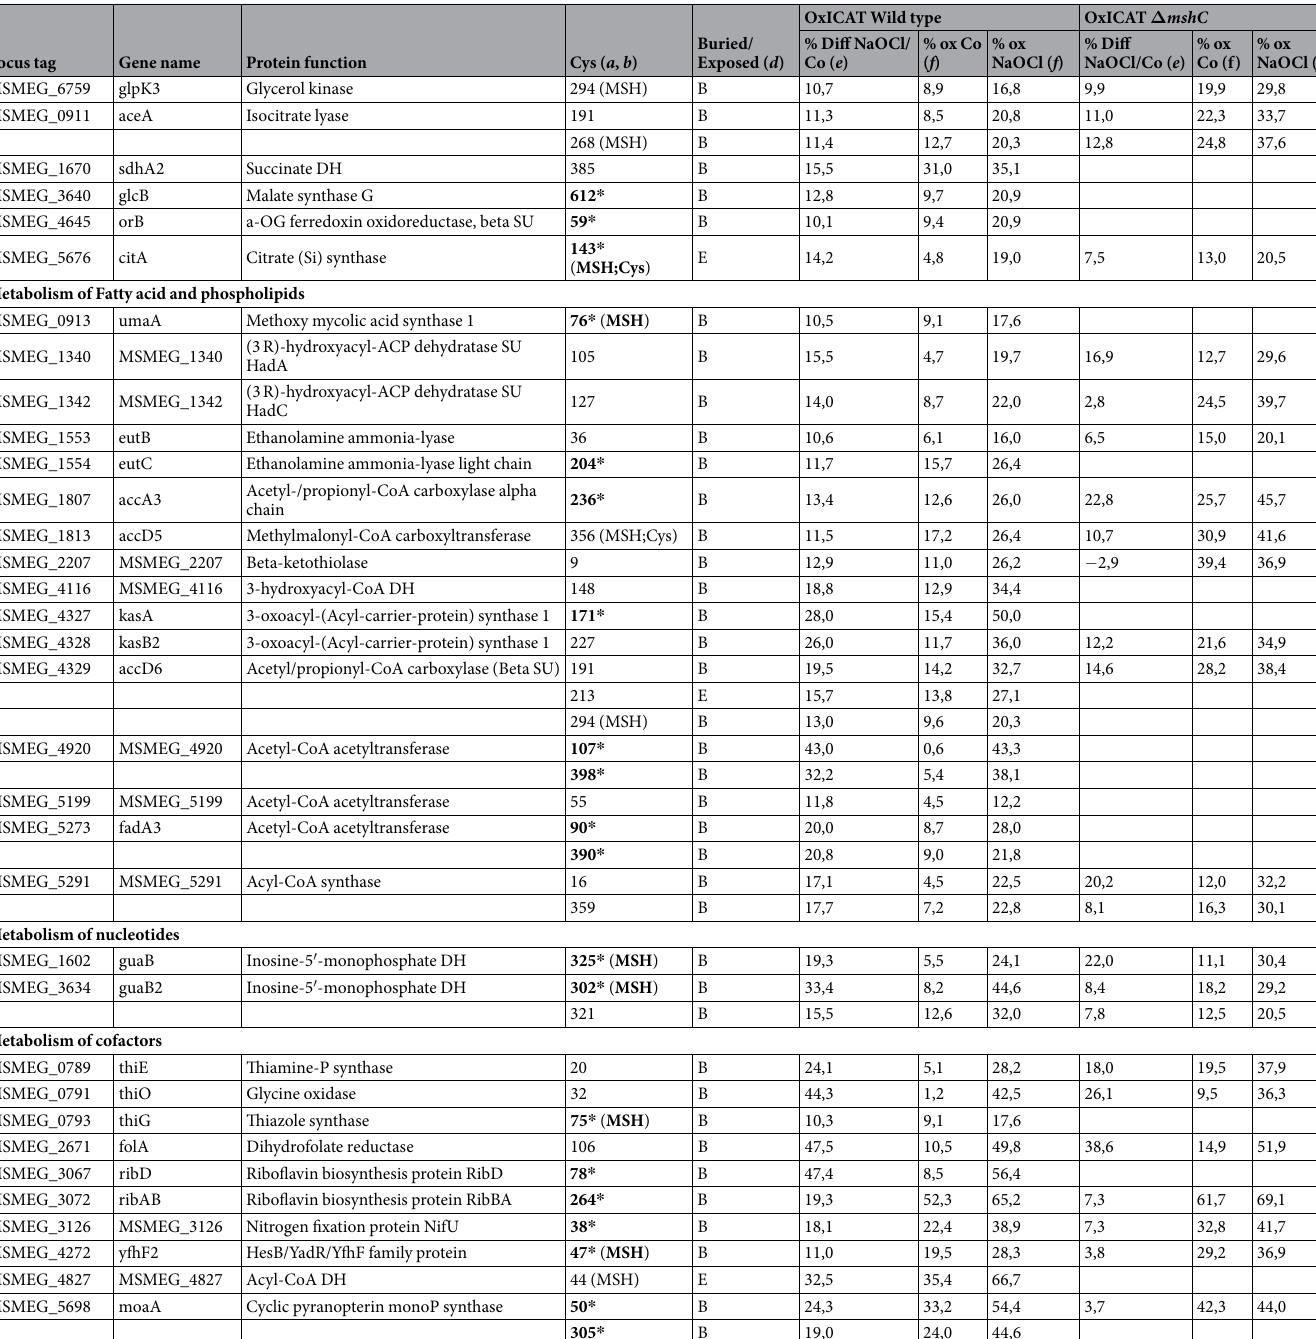
Table 2. Selected NaOCl-sensitive proteins with > 10% increased thiol-oxidations under NaOCl stress in M . smegmatis as revealed using the OxICAT method. Selected NaOCl-sensitive proteins with > 10% increased thiol-oxidations in response to NaOCl stress in M . smegmatis as revealed using the OxICAT method. The M . smegmatis wild type and mshC mutant were harvested before (control) and 30 min after exposure to 1 and 0.5 mM NaOCl, respectively. Reduced and reversibly oxidized Cys residues were labelled with light and heavy ICAT, respectively, using OxICAT. Quantification of % thiol-oxidations was performed using MaxQuant software. The table includes MSMEG accessions, protein names, functions, surface accessabilities and % oxidation of Cys residues under control and NaOCl. (a) Conserved Cys are bold. (b) S-mycothiolated or S-cysteinylated Cys are marked with ( + MSH) and ( + Cys). (d) Relative surface accessibility (RSA) for